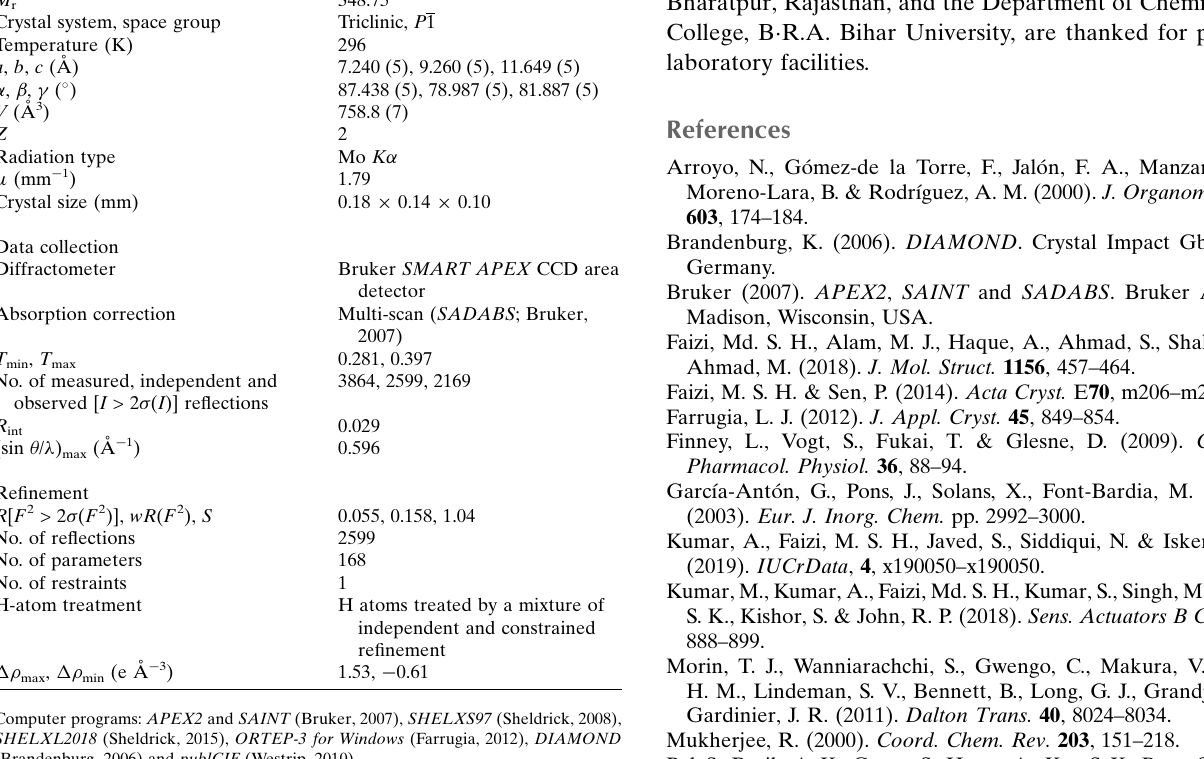
Table 2 Experimental details. Crystal data Chemical